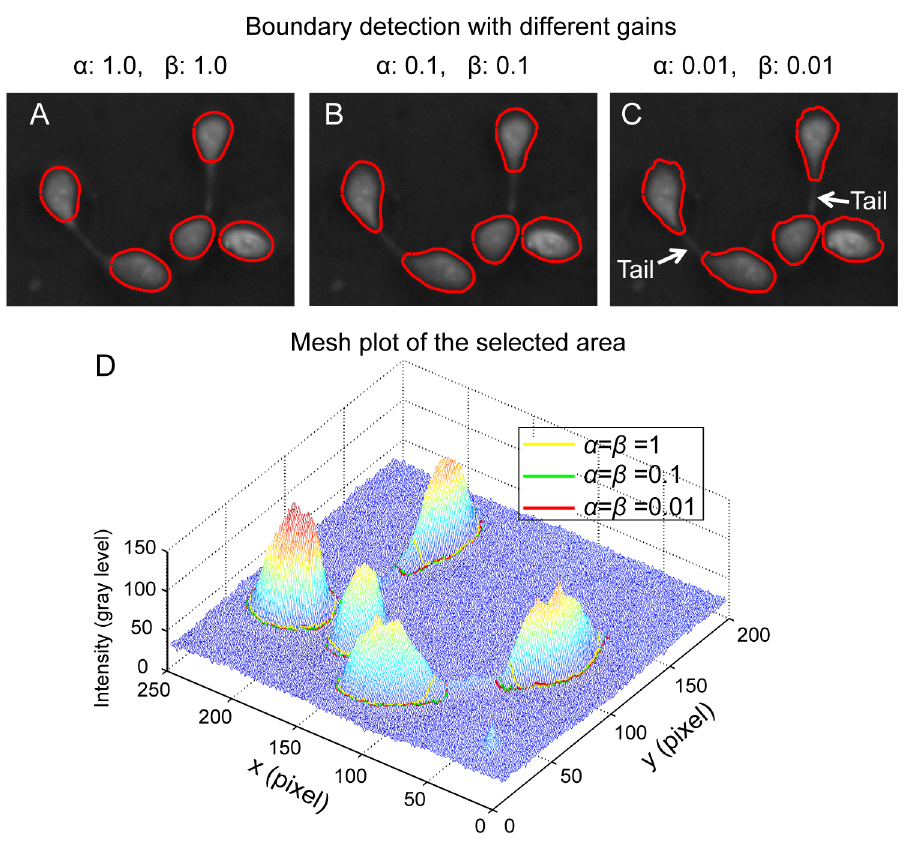
Fig 8. Contour expansion operation with different gains. (A) When the gains α and β are large, the internal energy dominates the evolution of contours and the contours tends to shrink to minimize the total energy. (B) With decreased gains, the final detected boundaries expanded and were closer to the cell boundaries. (C) When α and β further decreases to 0.01, optimized estimations of cell boundaries with more details are obtained. (D) Mesh plot of the selected area showing cells and converged contours with different combination of α and β . The combination α = β = 1 gives poor estimation of cell boundaries compared with the other two combinations.